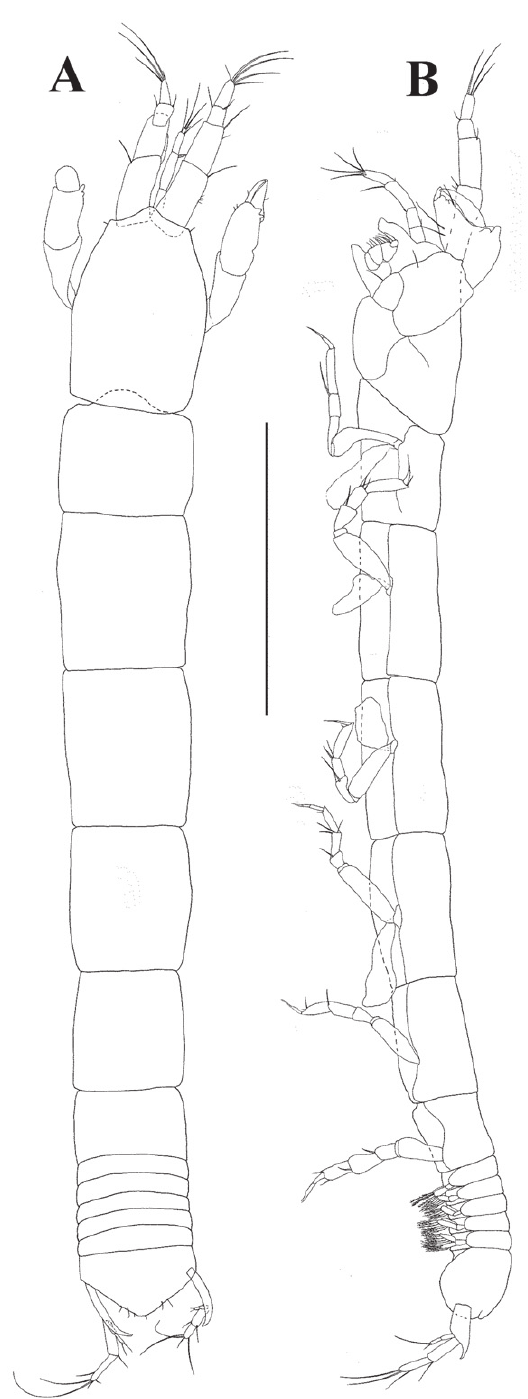
Figure 5. Tumidochelia tuberculata sp. n. Holotype A dorsal view B lateral view Scale bar 0.5